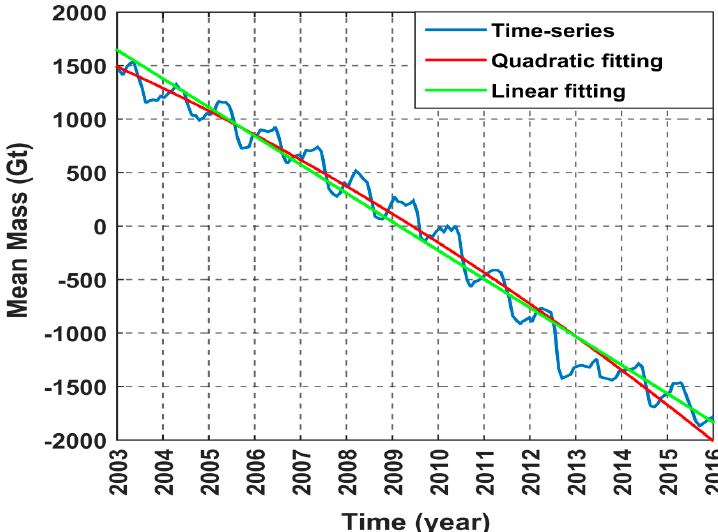
Figure 2. Monthly mass change of Greenland from January 2003 to December 2015 estimated based on the GRACE solution of the CSR processing center. The blue line, green line and red curve represent the mass change of the time series, and the best fitting of linear and quadratic trend, respectively.